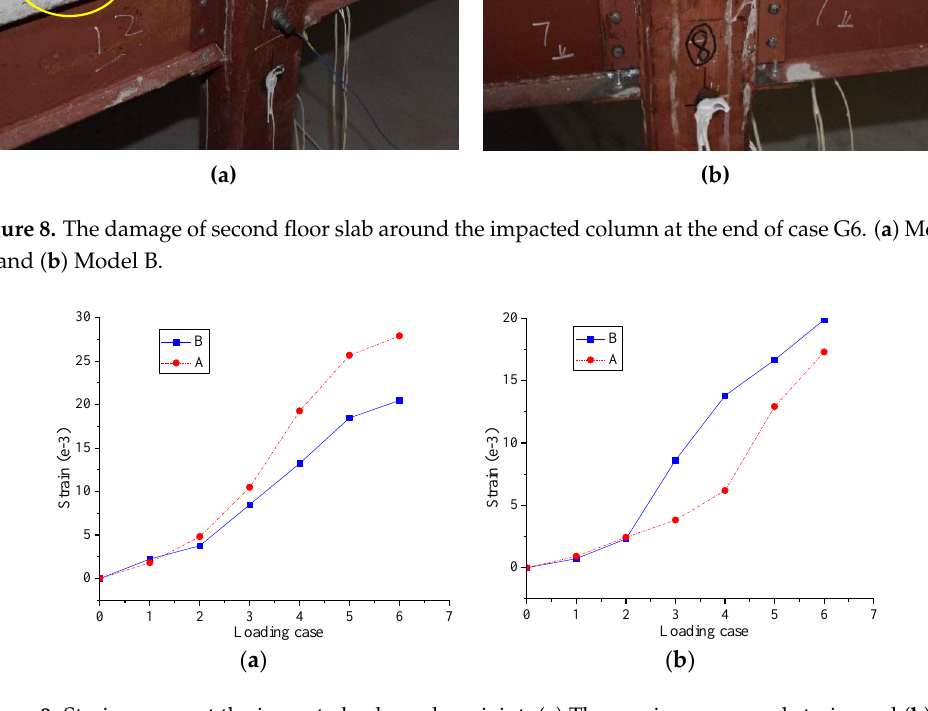
Figure 9. Strain curves at the impacted column base joint. ( a ) The maximum normal strain; and ( b ) the maximum shear strain of its side plate.